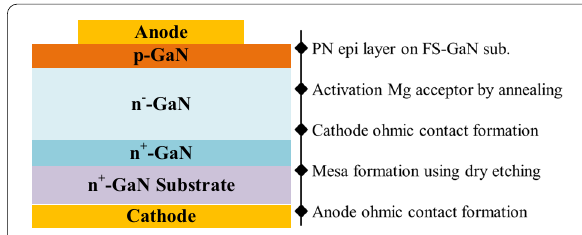
Fig. 3 Schematic structure and fabrication process of GaN vertical (as represented in Eq. 1 with applied voltage V for which V is positive/negative for the forward/reverse bias when the device is under reverse bias. Moreover, the break- down occurs with further increase in the reverse bias.